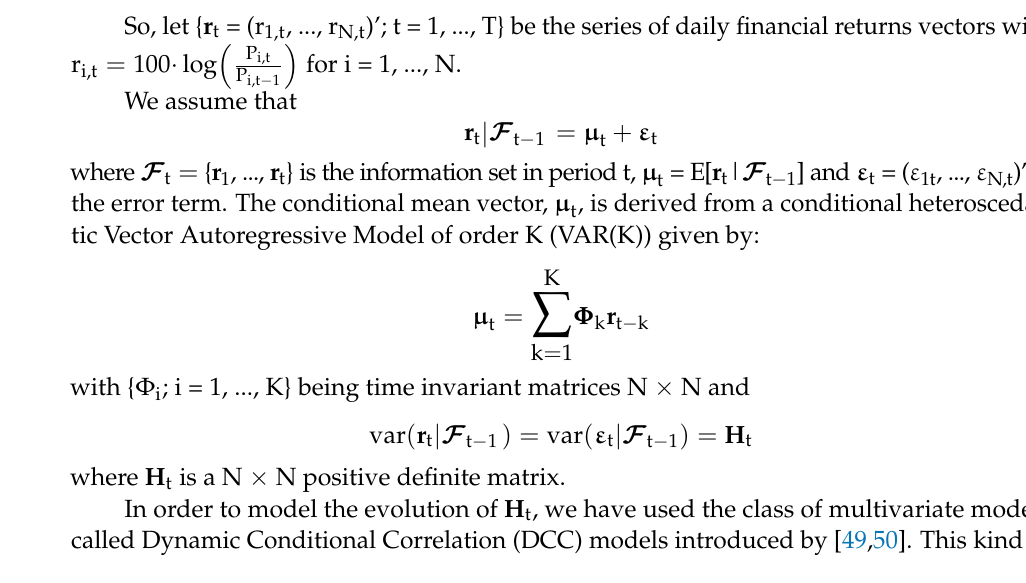
Figure 2. Matrix graph with the evolution of the daily returns of the seven